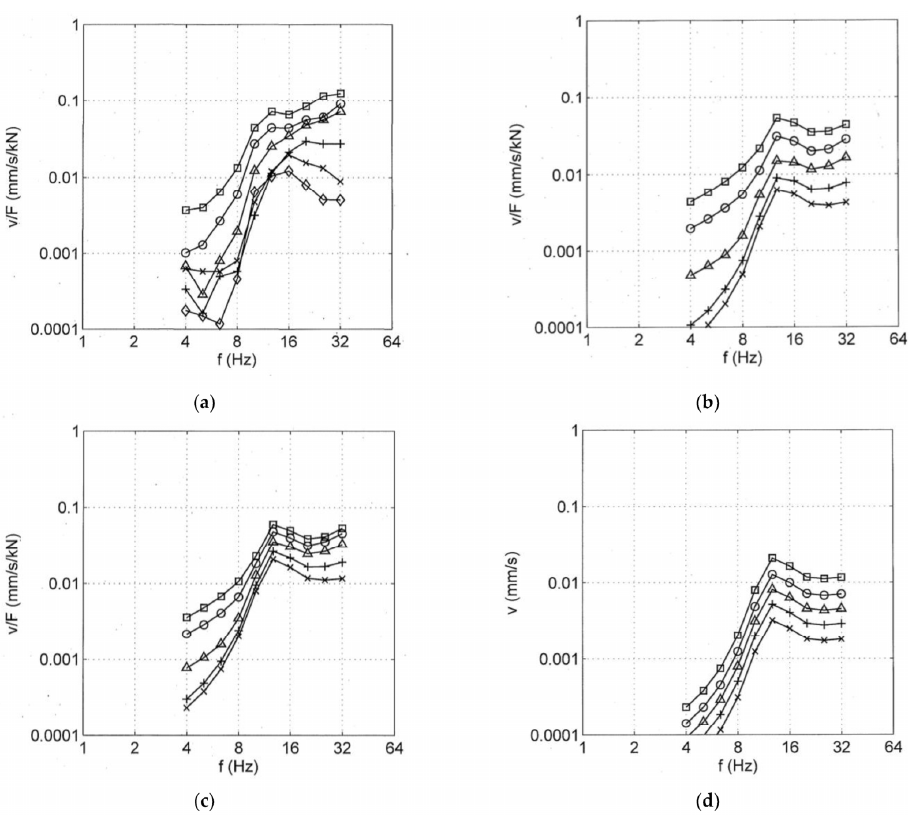
Figure 9. Transfer functions for the soil at site W, distances x = □ 3, ○ 5, ∆ 10, + 20, × 30 m, ( a ) measured from hammer impact, ( b ) calculated for a point load, ( c ) calculated for a standard train load; ( d ) response to constant train loads between 0.15 and 1 kN per one-third octave band representing train speeds of v T = □ 160, ○ 125, ∆ 100, + 80, and × 63 km/h.